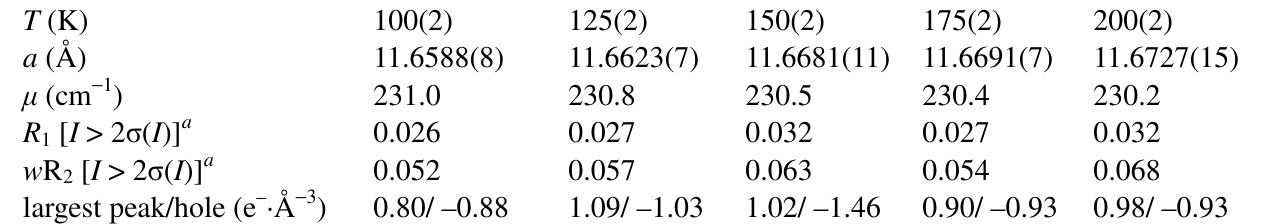
Table 2. Selected structure refinement parameters for Ba the temperature range 100–200